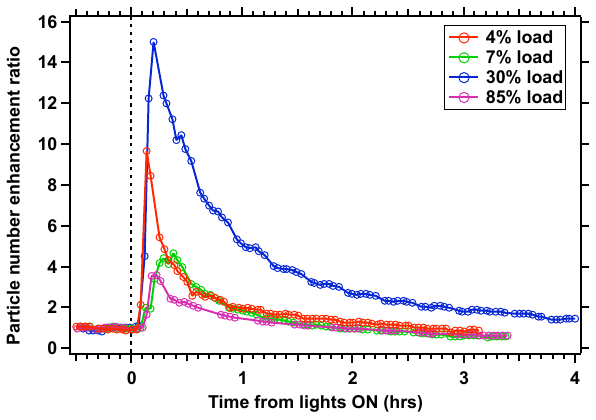
Fig. 4. Time-series of the wall-loss corrected particle number en- hancement ratio for all engine loads. This ratio is defined as the ratio between the particle number at any point in the experiment and the particle number in the chamber during the primary characterization